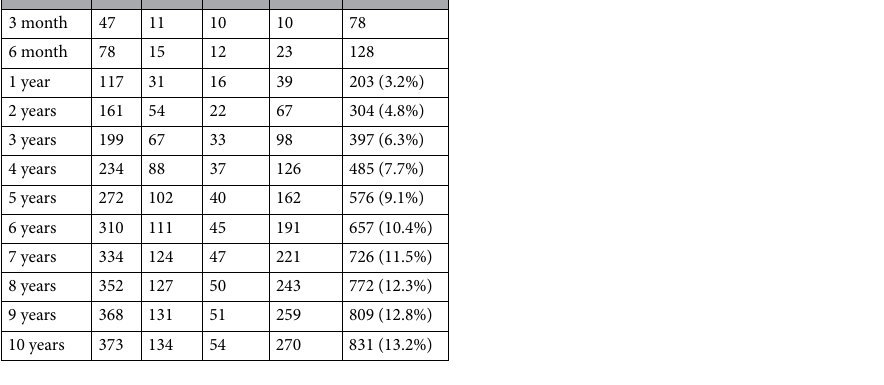
Table 3. Cumulative number and incidence of reoperation. OD, Open discectomy; Lami, Laminectomy; PELD, Percutaneous endoscopic lumbar